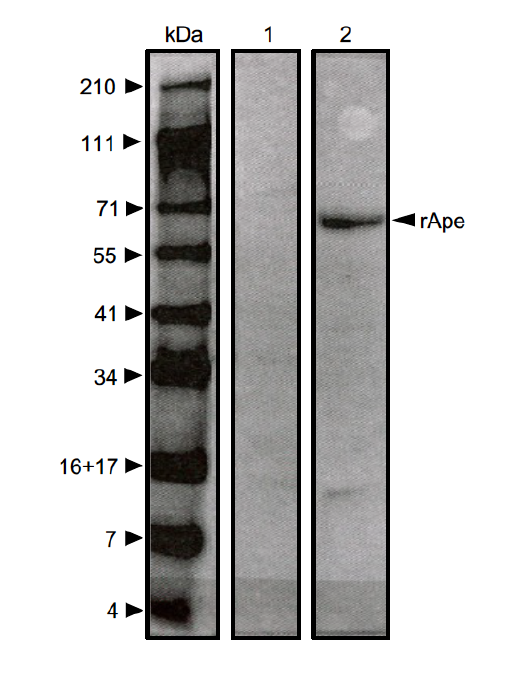
Figure 3. rApe is an O-glycosylated recombinant protein. Composite picture of a Western blot detecting O-glycosylation of recombinant Ape protein (lane 2). Recombinant proteins were separated by SDS-PAGE, then transferred to PVDF and incubated with anti-O-GlcNAc antibody. The Western blot was probed with anti-mouse IgM-HRP antibody and revealed by TMB substrate. Lane 1: negative control : BSA; lane 2: rApe. Numbers and black arrowheads indicate molecular masses in kilodaltons (kDa). The recognized rApe is significantly larger (66 kDa) than the one predicted by the amino acid sequences encoded by ERGA_CDS_01230 gene (41